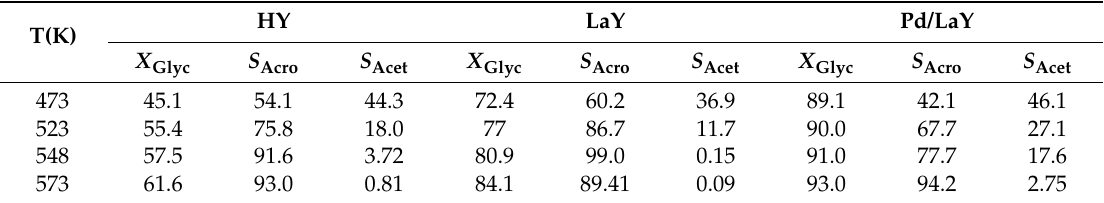
Table 2. Glycerol conversion and selectivities to acrolein and acetol of the HY, LaY, and Pd/LaY catalysts at different temperatures. (10 wt % glycerol, 0.3 g of catalyst and gas hourly space velocity (GHSV) = 5933 h − 1 )